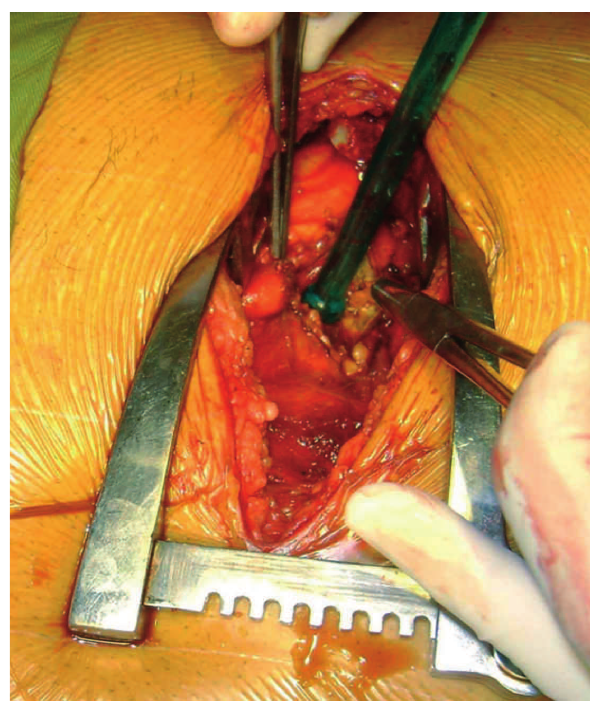
Fig. 2 – Esternotomia mediana, demonstrando o cisto pericárdico aberto com seu conteúdo sendo